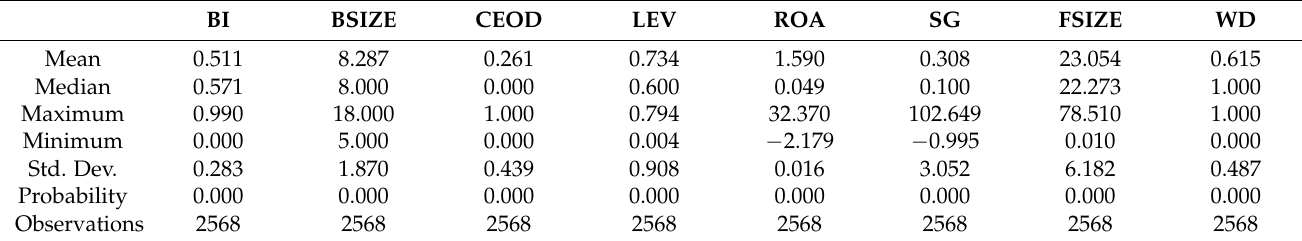
Table 3. Descriptive statistics.